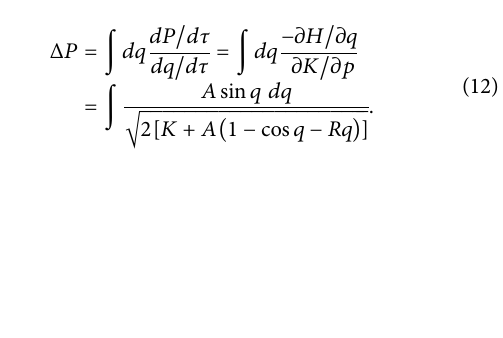
Contours of K , from Eq. 11, are shown in the top panel of Figure 4. The linearly unstable X -point obeys tan q x (cid:2) R / and the stable O -point obeys tan q o (cid:2) R / (− branch choices − 2 π < q x < − 3 π /2 and − 3 π /2 < q o < − π . The value q turn is the second location where the curve through an X - point crosses p = 0, with q x < q o < q turn < q x + 2 π . Finally, q * refers